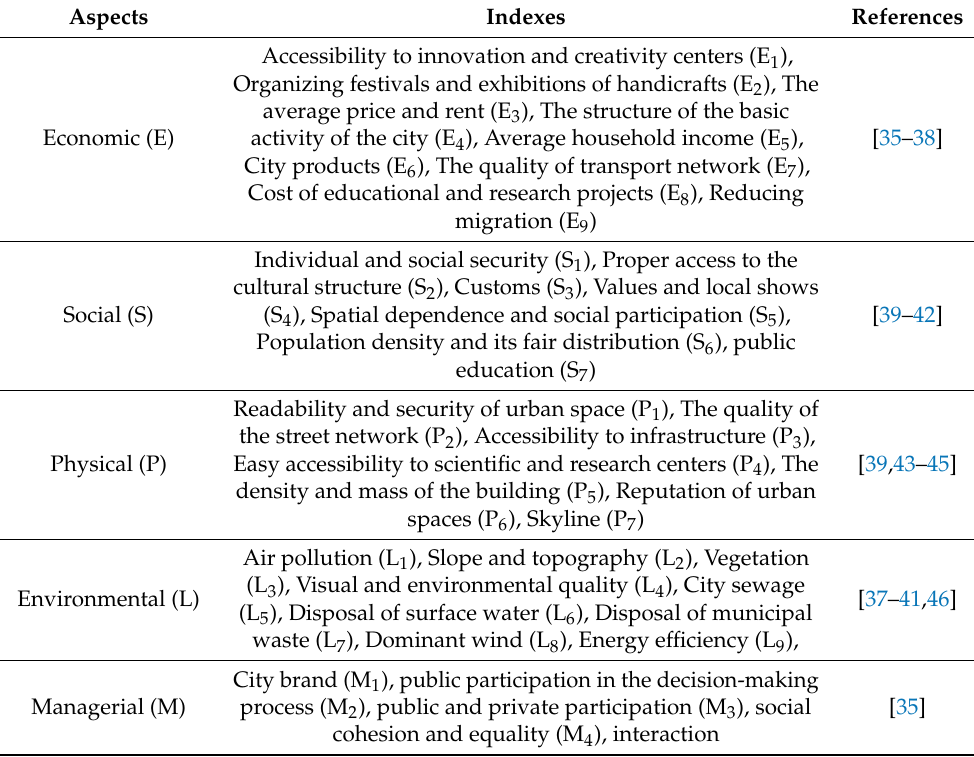
Table 1. Urban planning indicators.